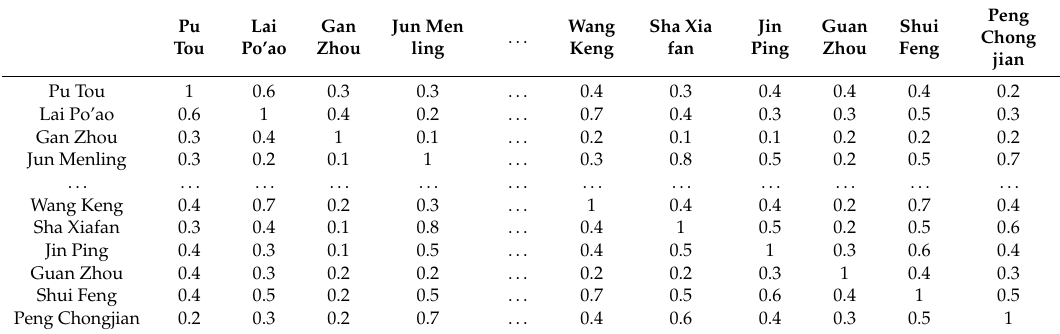
of the clustering ensemble. The partial results of the matrix are shown in Table 3: Table 3. Cross-correlation matrix obtained by clustering collectively based on the data set of small and medium watersheds in Jiangxi Province. Pu Lai Gan Tou Po’ao